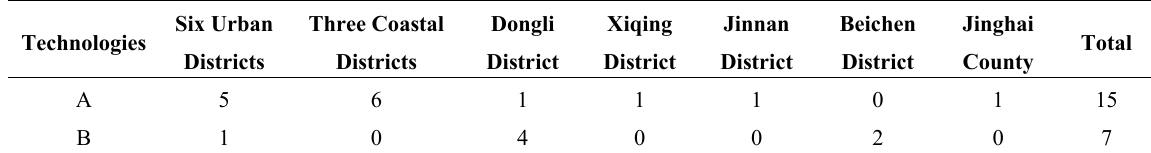
Table 5. Regional installation plan for Technology A and